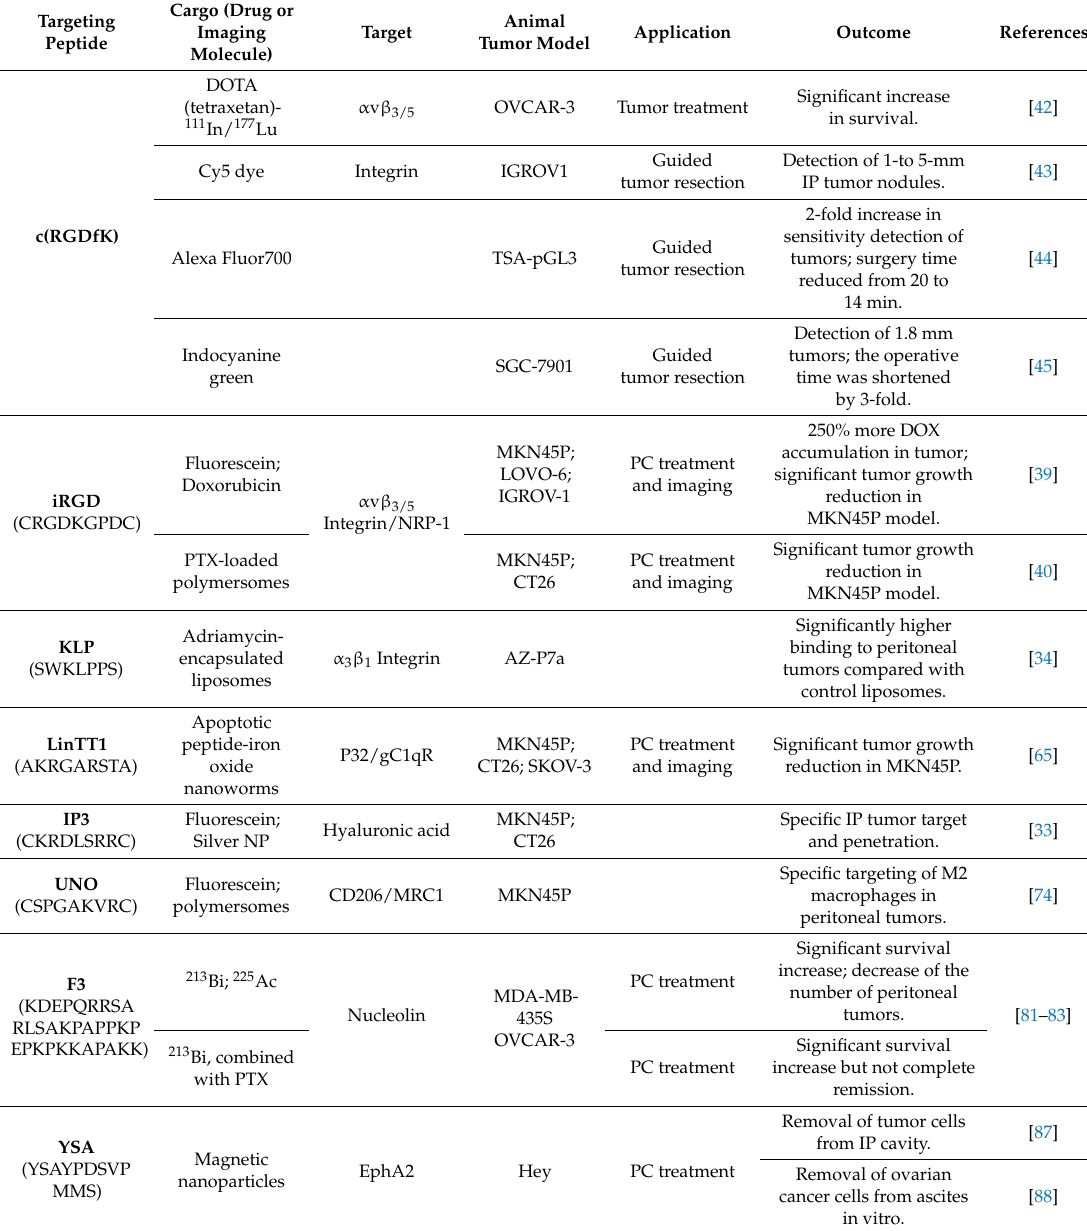
Table 1. Peptide-targeted systems for treatment, imaging and guided surgery of PC. Targeting